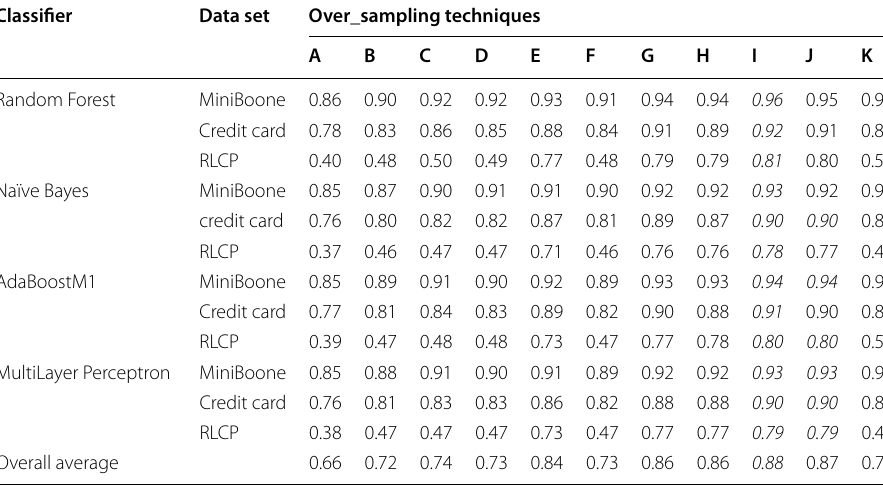
Italic values indicate highest result Table 12 F-measure value for UCPMOT_MEMMOT Data